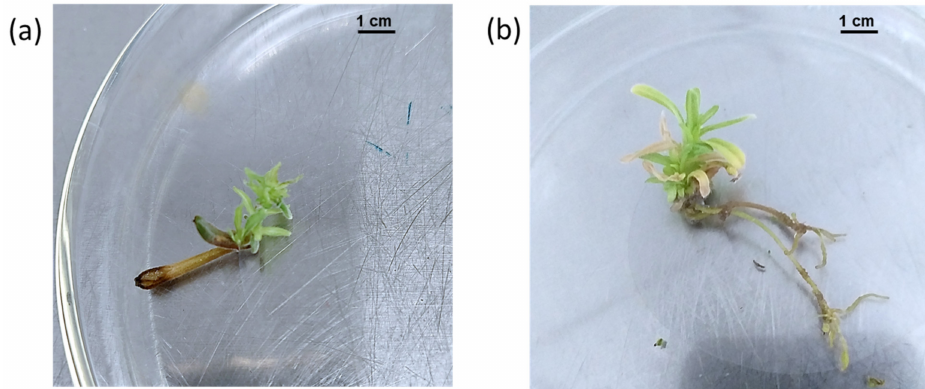
Figure 3. ( a ) Effect of half-strength MS medium supplemented with 4.4 µ M BAP and 1.4 µ M GA 3 on C. montanus microshoot growth after four weeks of incubation; ( b ) Effect of half-strength MS medium supplemented with 3.9 µ M IBA on in vitro rooting of C. montanus after four weeks of incubation.